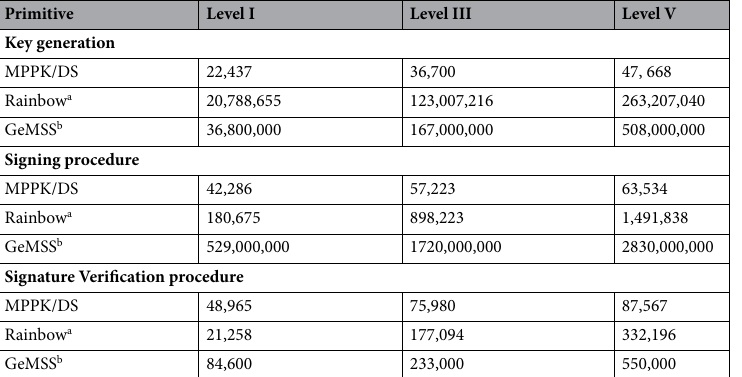
Table 6. Performance of the the MPPK/DS scheme as well as the NIST PQC Round 3 multivariate DS schemes, with values given in clock cycles. a The rainbow1aclassic363232 primitive was measured for Level I, rainbow3cclassic683248 for Level III, and rainbow5cclassic963664 for Level V. b GeMSS128 primitive corresponds to values for level I, GeMSS192 corresponds to values for level III, and GeMSS256 corresponds to values for level V.